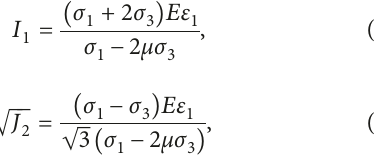
Figure 4: Mechanical model of the rock